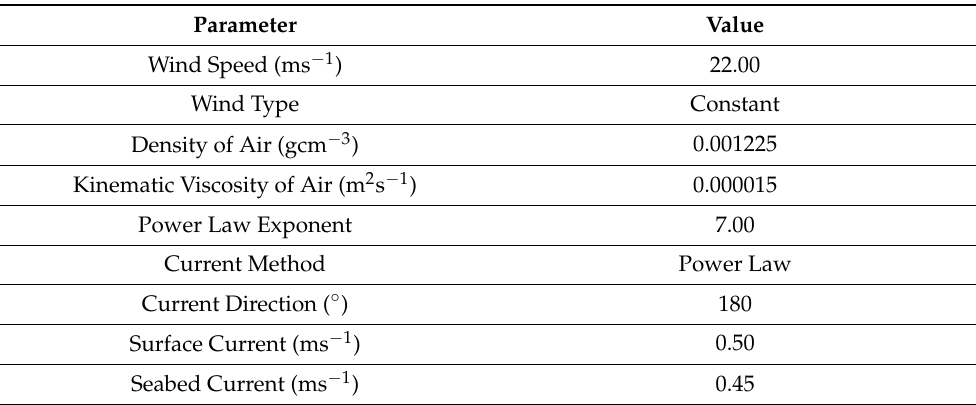
Table 8. Wind and Current